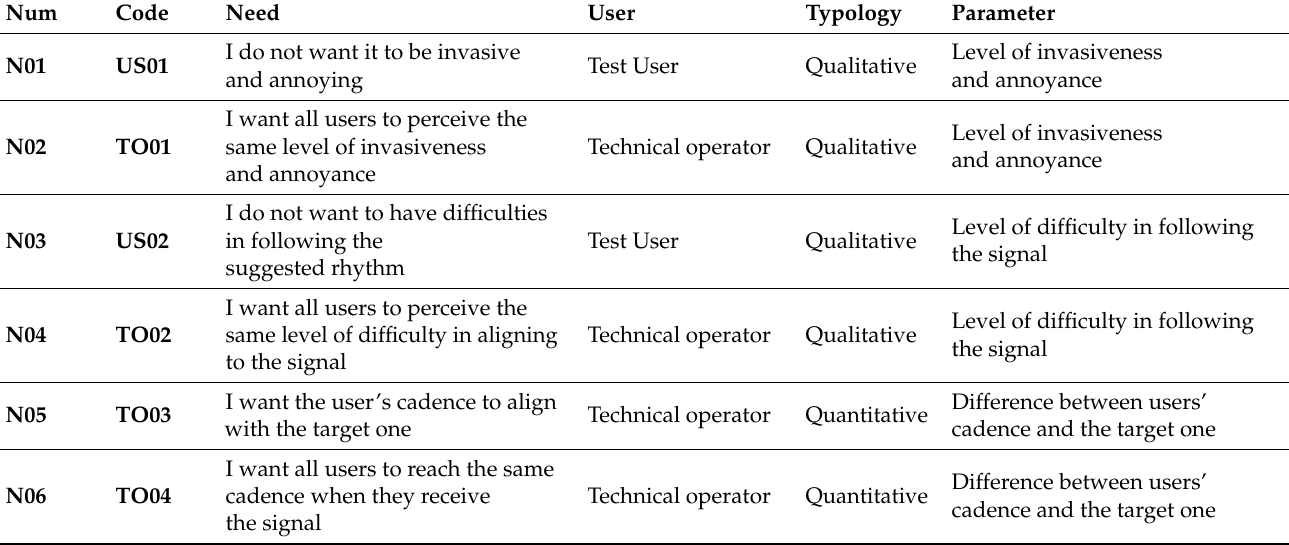
Table 2. Needs for the QFD